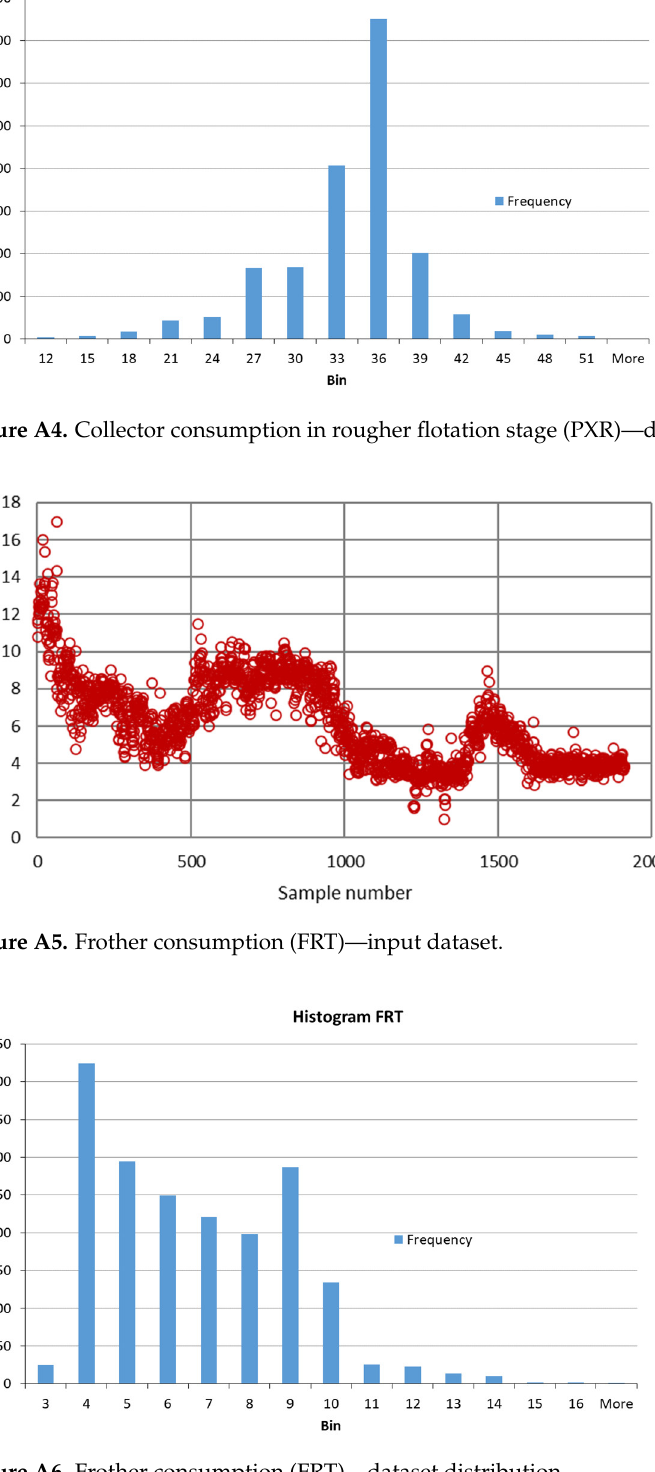
Figure A6. Frother consumption (FRT)—dataset distribution.